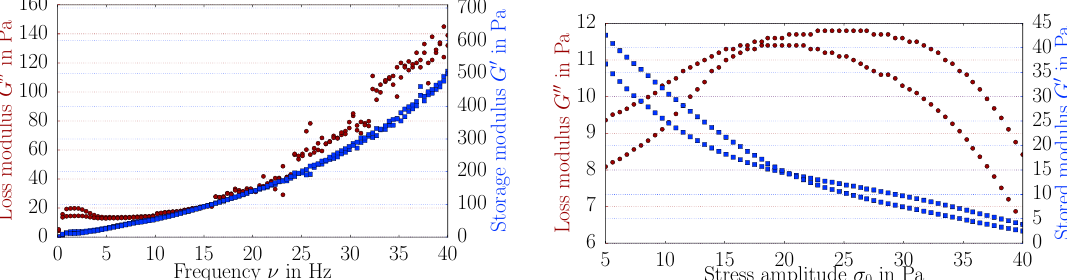
Figure 1. Output from the oscillatory measurement. Left: Frequency variation by fixed amplitude, σ 0 = 40Pa. Blue squares denote the storage moduli, and red dots indicate the loss moduli. Right: Amplitude variation by fixed frequency, ν = 1Hz. Blue squares denote the storage moduli, and red dots indicate the loss